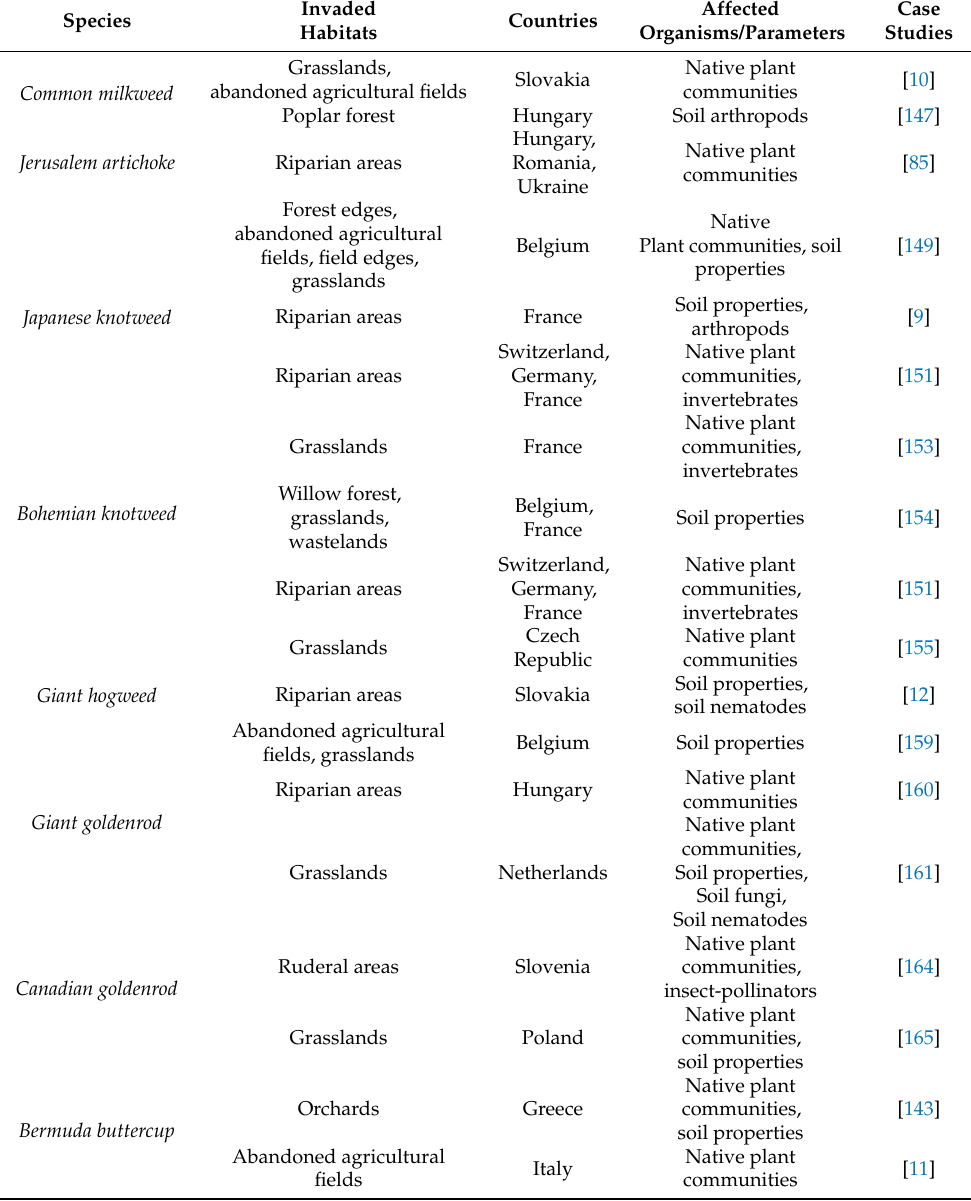
potential allelopathic effects have been isolated from root extracts of both species [166,167]. Table 2. Representative case studies on the impact of invasion of selected alien plant species on biodiversity in different habitats in European